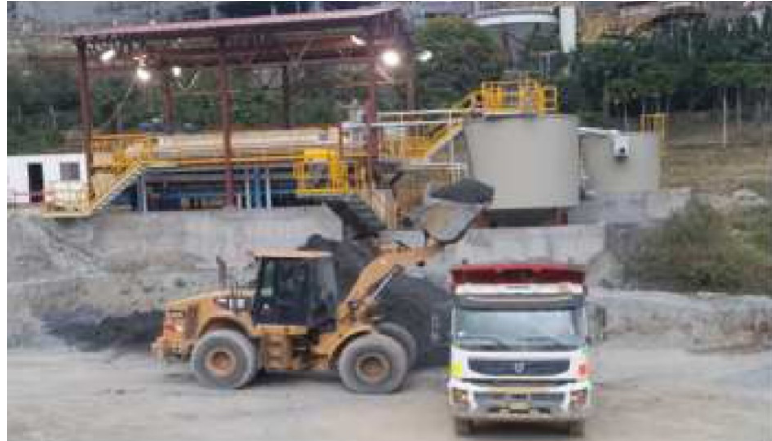
Figure 58. Poderosa Filtered Tailings Plant [36,37].